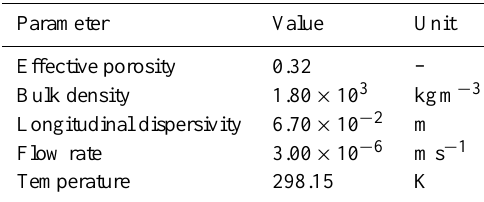
Table 2. Material properties of the 1-D calcite column.